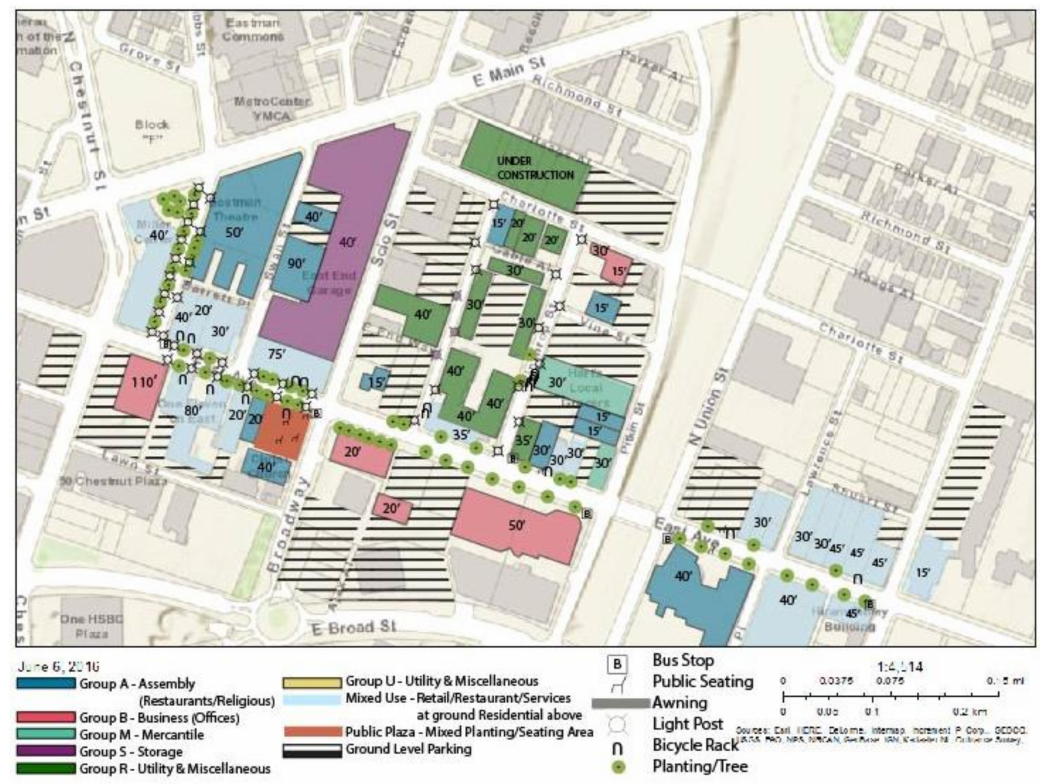
Figure 4. East End urban form and pattern map (By authors).